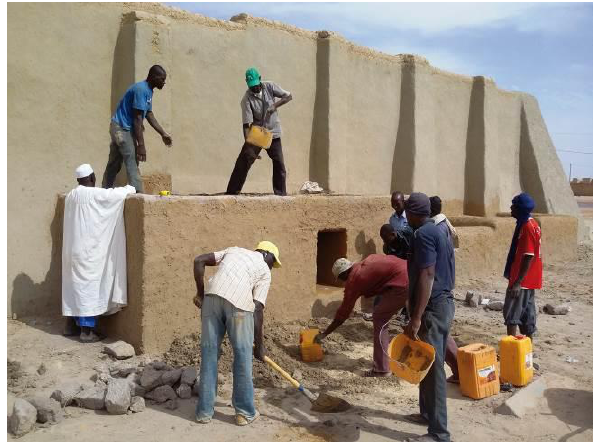
Figure 4. The pilot reconstruction project at the juxtaposed mausoleums of Cheikh Sidi Mahamane al Foulani and